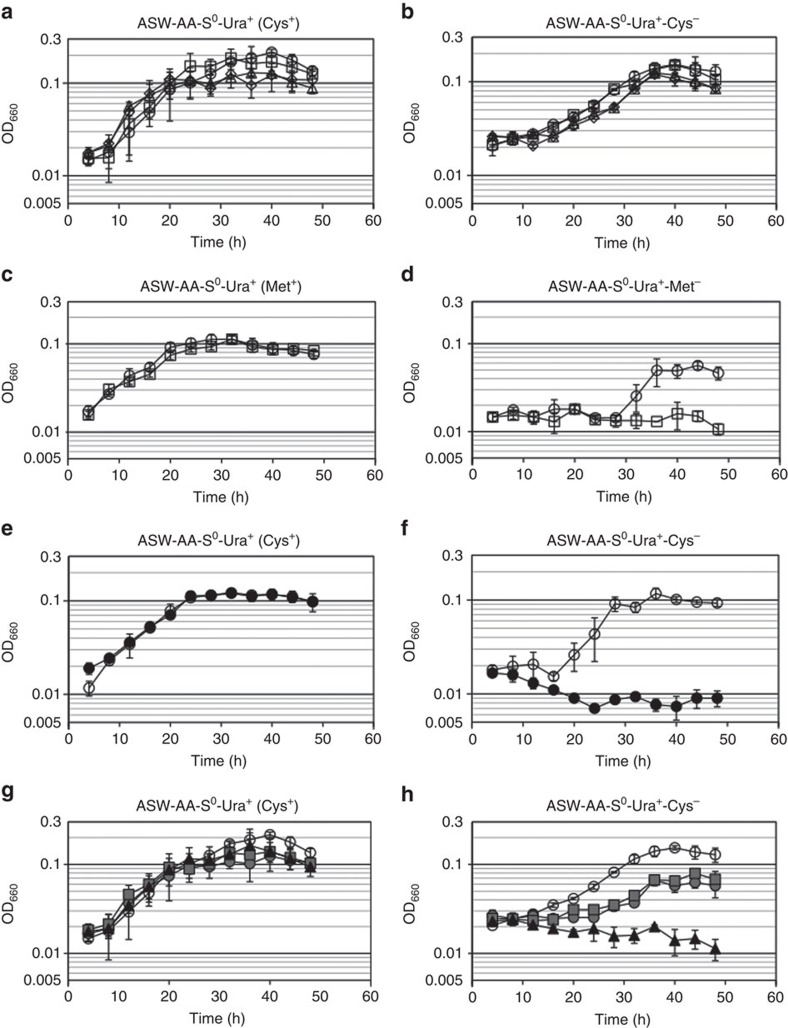
Cys or Met auxotrophy of Thermococcus kodakarensis gene disruptants.(a,b,e–h) Cys auxotrophy was investigated by cultivating cells in ASW-AA-S0-Ura+ medium with (a,e,g) or without Cys (b,f,h). Symbols: T. kodakarensis KU216 (open circles), Δtk1449-2-1-2 (open squares), ΔserAΔldhA1ΔldhA2-1 (open triangles), Δtk1449ΔserAΔldhA1ΔldhA2-2 (open diamonds), ΔcysK-3 (black circles), ΔserK-1 (grey circles), Δtk1449ΔserK-1 (grey squares) and ΔserAΔldhA1ΔldhA2ΔserK-1 (black triangles). (c,d) Met auxotrophy was examined by cultivating cells in ASW-AA-S0-Ura+ medium with (c) or without Met (d). Symbols: T. kodakarensis KU216 (open circles) and Δtk1449-2-1-2 (open squares). Error bars indicate the standard deviations of three independent culture experiments.